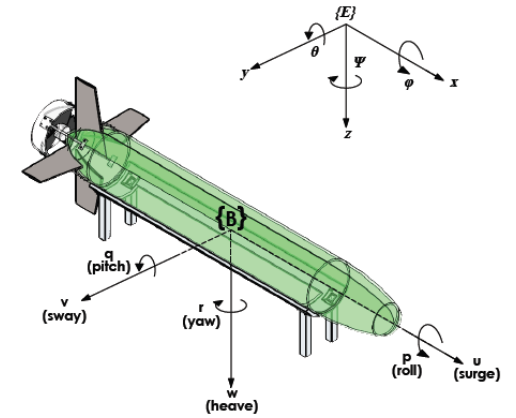
Figure 1. Earth-fixed frame and Body-fixed frame of